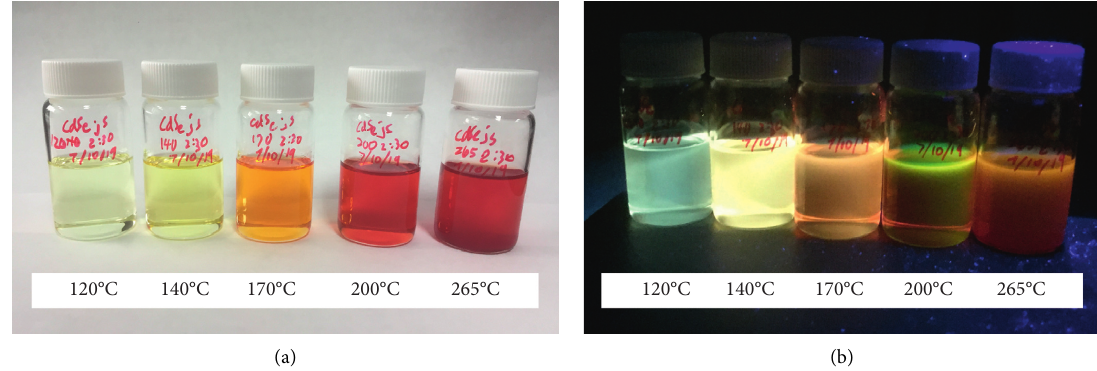
Figure 1: Array of quantum dots in glass vials immediately after microwave synthesis under visible light (a) and under 365nm UV light (b). From left to right, hold temperatures were 120 ° C, 140 ° C, 170 ° C, 200 ° C, and 265 ° C, with hold time remaining constant at 2min 30s.